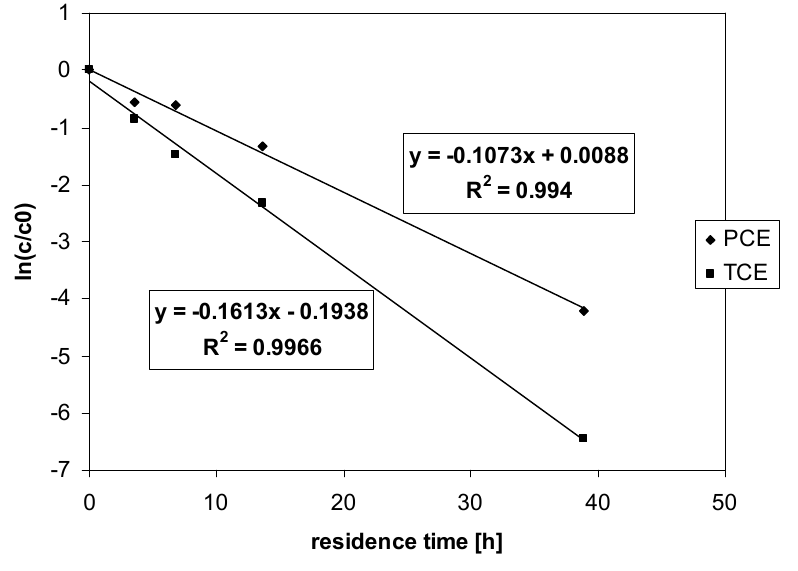
Fig. 4 First-order rate kinetics of PCE and TCE